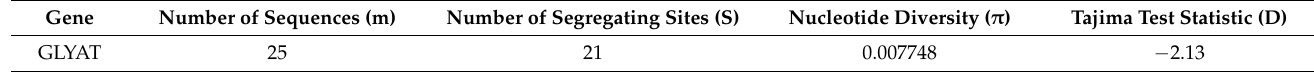
Table 2. Results from Tajima’s neutrality